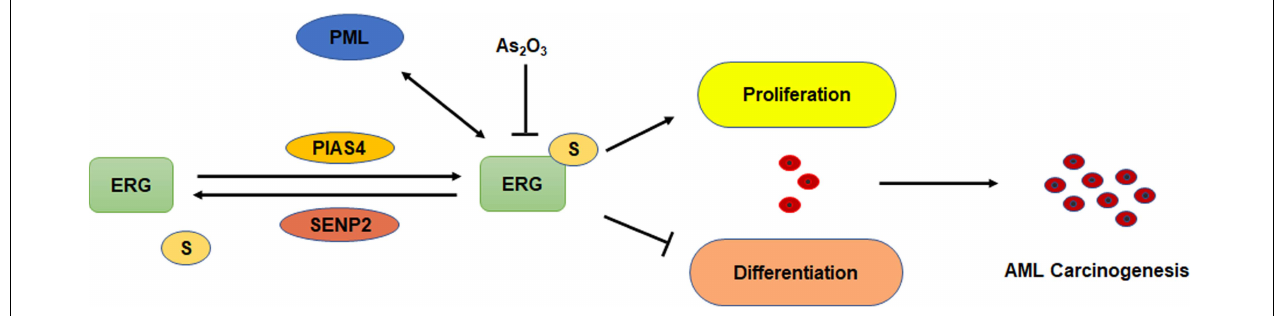
FIGURE 8 | Schematic model depicting the role of SUMOylation of ERG in the regulation of cell proliferation and differentiation of AML